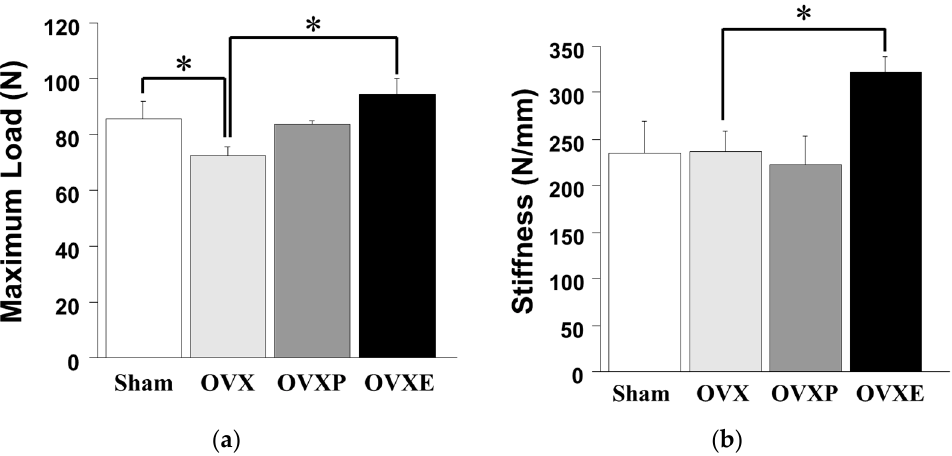
Figure 3. Strength testing results for the femoral head. ( a ) Maximum load and ( b ) stiffness. * p < 0.05.